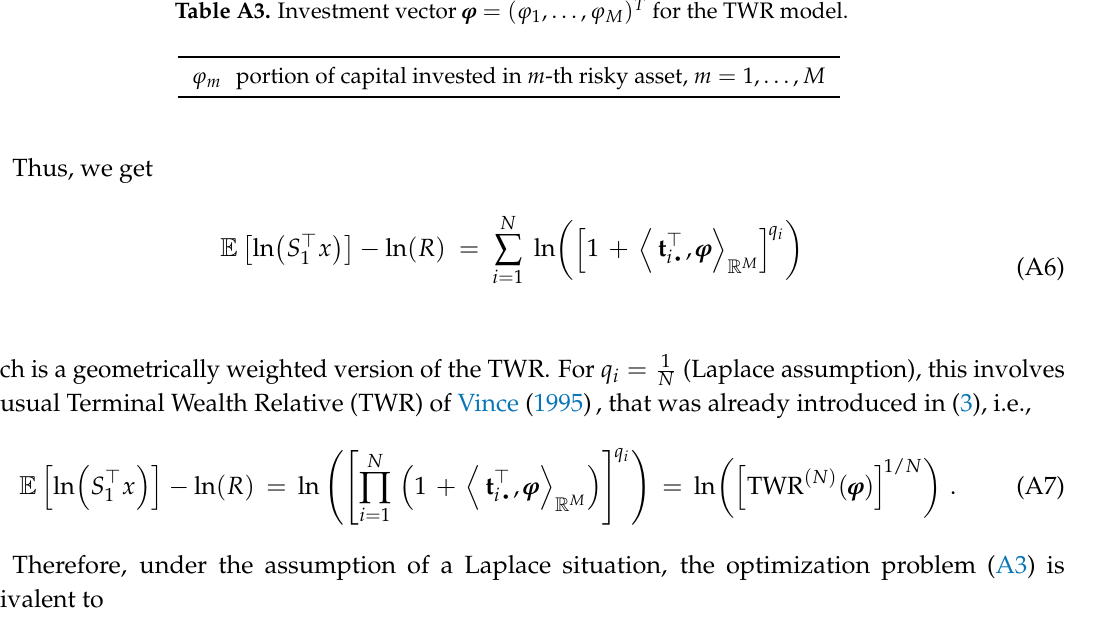
Table A3. Investment vector ϕ = ( ϕ 1 , . . . , ϕ M ) T for the TWR